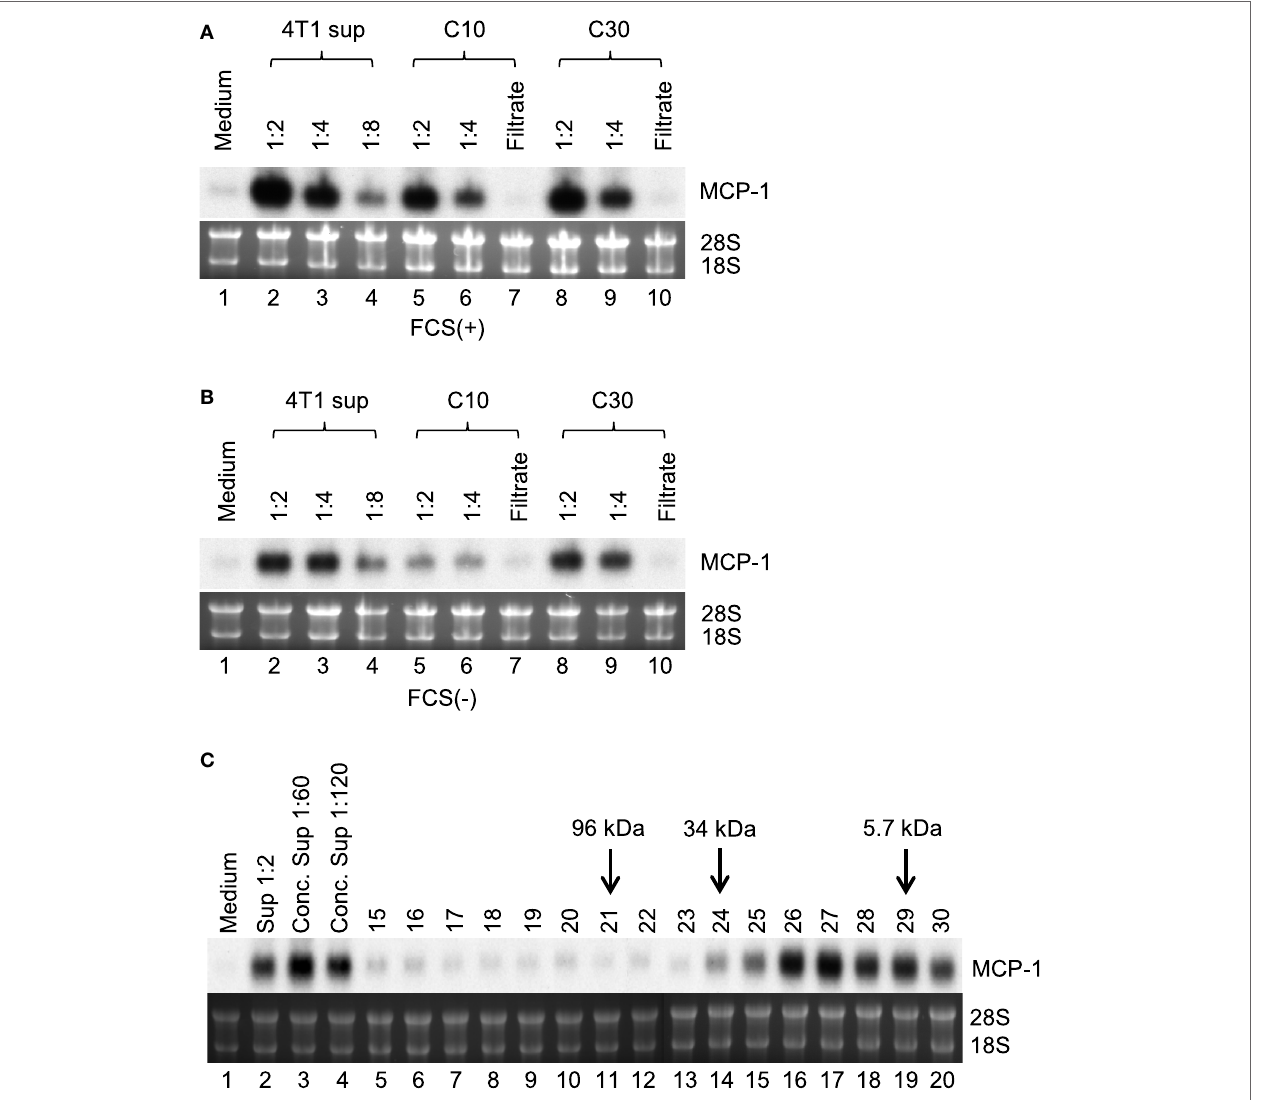
FigUre 3 | Partial characterization of McP-1-inducing activity in 4T1-sup. Cell-free 4T1-sup containing 10% FBS (a) or without FBS (B) was concentrated by using Amicon Centriprep 10 or 30, and then total volume was adjusted to the original volume by adding RPMI-1640. MCP-1-inducing activity was examined by Northern blotting. (c) Thirty milliliter of 4T1-sup containing 1% FBS was concentrated by CentriPrep, filtered, and injected into a TSK-2500 column. Four hundred micro liter fractions were collected and assayed for MCP-1-inducing activity at 1:10 dilution. The fractions to which molecular mass markers were eluted are indicated by